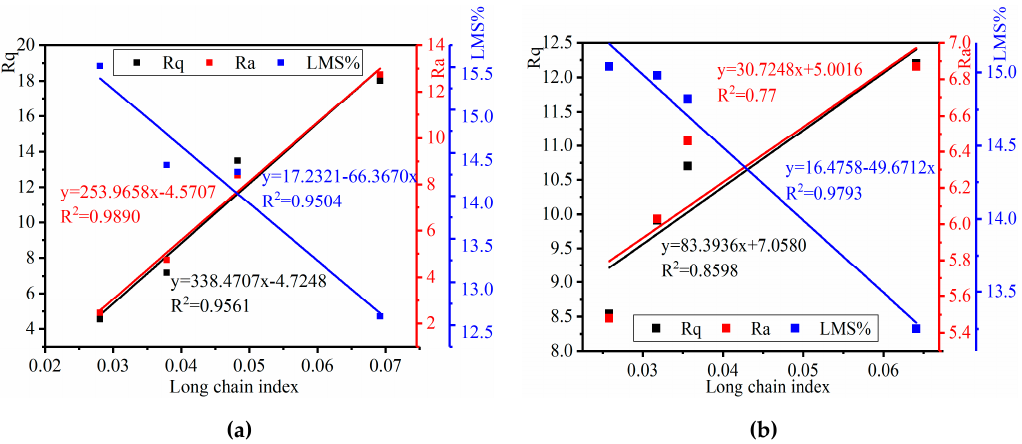
Figure 17. Relationship between the long-chain index, LMS%, and AFM roughness. ( a ) Base mastics; ( b ) SBS-modified mastics.